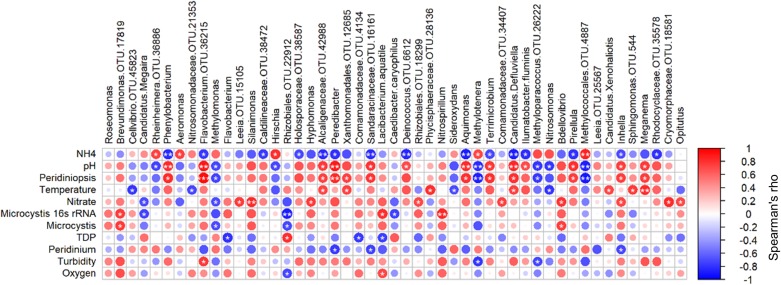
Spearman cross-correlations between relative abundance of significantly associated OTUs and environmental parameters. Starred circles represent significant correlation (one star: 0.01 < p < 0.05, two stars: p < 0.01). OTU numbers indicated for genera in which more than one OTU was identified. Peridiniopsis, Peridiniopsis population (mm2/mm3), Microcystis, Microcystis population (mm2/mm3), TDP, total dissolved phosphorus, (mg/l), Peridinium, Peridinium population (mm2/mm3). Analysis was performed using ‘psych’ package in R (Revelle, 2013).